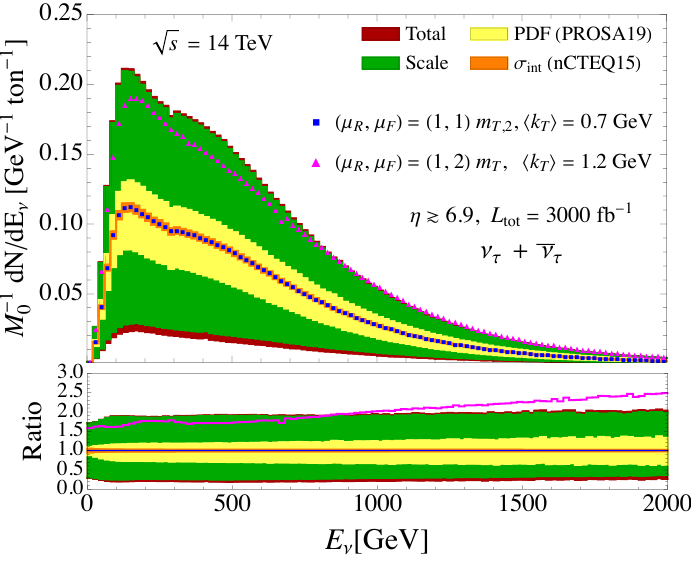
Figure 22. The same as figure 18, except for the pseudorapidity range and the integrated lumi- nosity, which in this plot are set to η ν > 6 . 9 and L = 3000 fb − 1 .